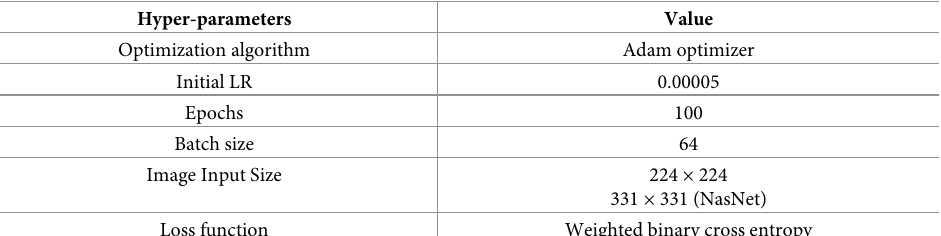
Table 2. Setting of deep learning